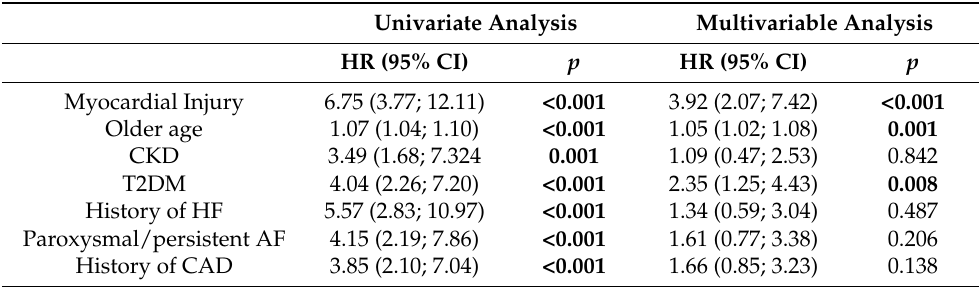
Table 4. Predictors of MACCE in the overall population by univariate and multivariate Cox regression